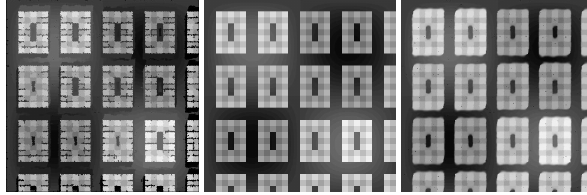
Figure 8: Filled DSM with described approach (left), reference (center), and DSM filled with inverse distance weighted interpo- lation (right)